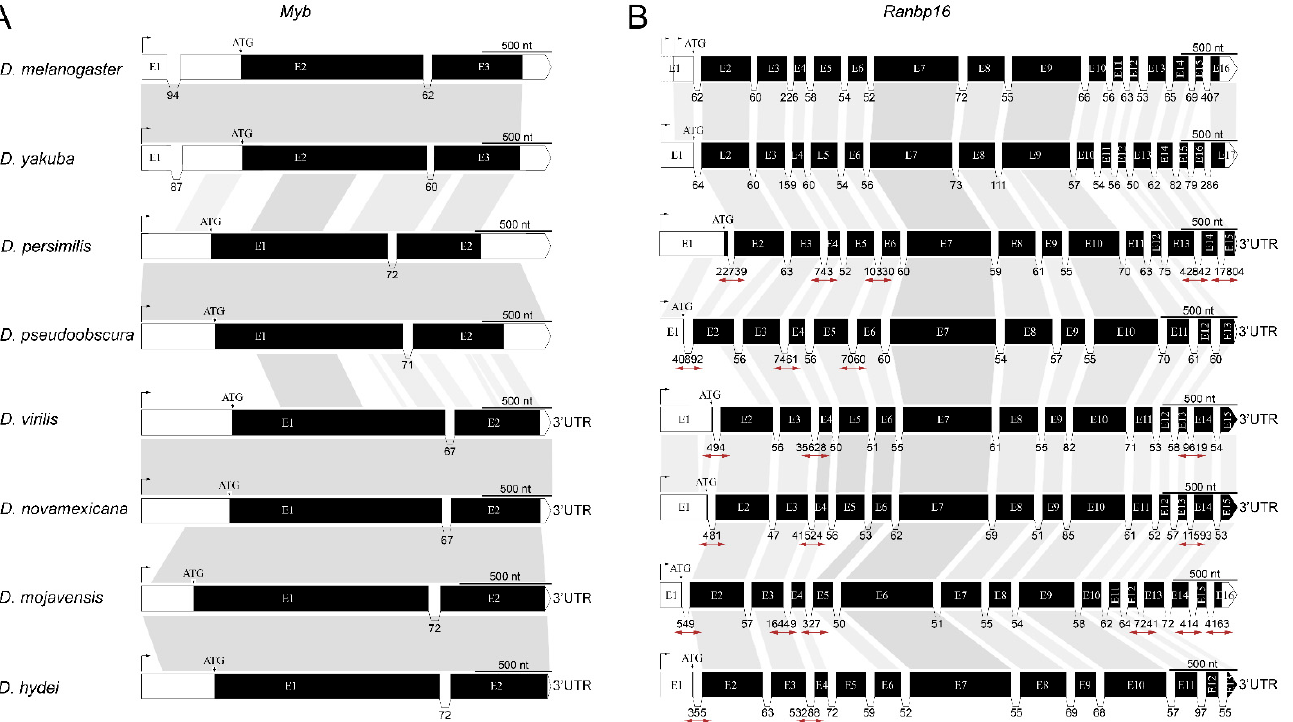
Figure 3. Comparative gene organization of Myb ( A ) and Ranbp16 ( B ) genes among eight Drosophila species. White and black regions on the scheme denote untranslated and coding regions, respectively. The grey area between genes indicates homologous regions defined using nucleotide BLAST basing on the percentage of identity not less than 70. Homology of introns is shown only for the Myb gene. The rightwards corner arrow at the beginning of genes indicates the transcriptional start site. Due to the large length of some introns in most Drosophila species, all introns of Ranbp16 are shown not in their real sizes. Numbers underneath the introns reflect their size in nucleotides. Introns that were increased in size by transposable element insertions are highlighted by red bidirectional arrows. The 3 ′ untranslated regions (3 ′ UTR) are not given for most of the genes due to the absence of their annotations and homology to those from closely related species.